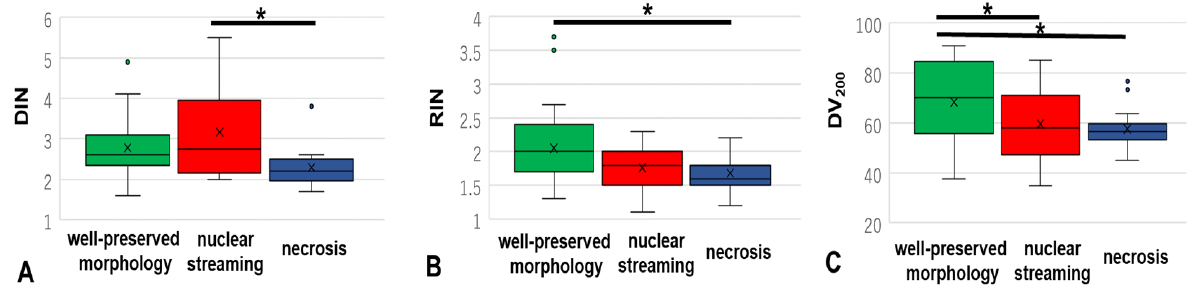
Figure 2. Differences in DIN ( A ), RIN ( B ), and DV 200 ( C ) among the materials with well-preserved morphology, nuclear streaming, and necrosis groups in SC and DLBCL samples. DIN, DNA integrity number; RIN, RNA integrity number; SC, small cell lung carcinoma; DLBCL, diffuse large-B-cell lymphoma. (*, p < 0.05). Table 1. Comparison of DNA integrity number, RNA integrity number, and DV 200 between the three histological groups.